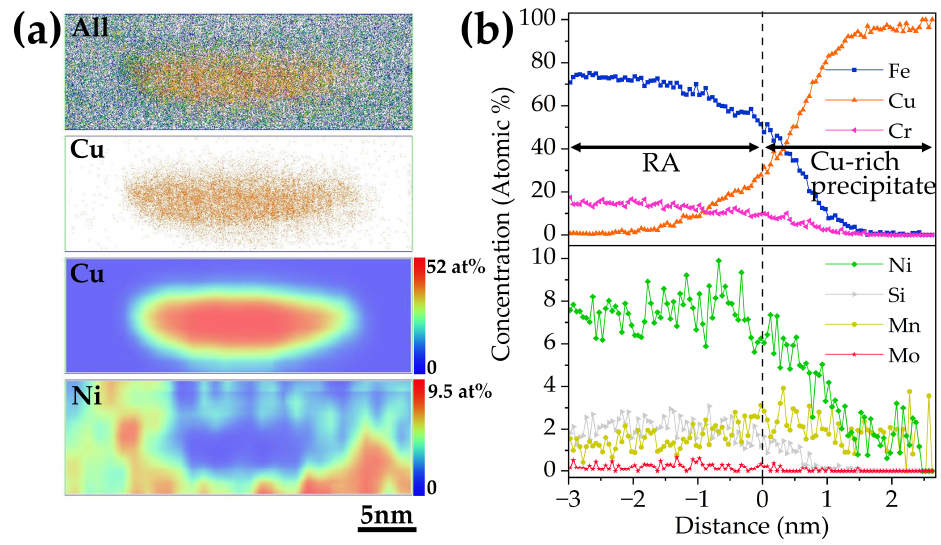
Figure 11. ( a ) The 3-D atomic mappings and 2-D concentration mappings of Cu and Ni in the Cu-rich precipitate displayed in Figure 10a. ( b ) The corresponding proximity histogram of the Cu-rich precipitate.